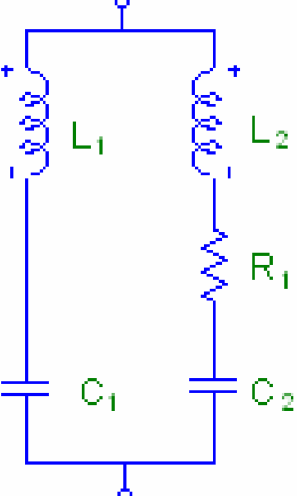
FIG. 2. (Color) Circuit drawing of each of 38 modified Marx generator stages. Here C (cid:5) 5 (cid:2) H , and the coupling between L 440 (cid:2) H , L 2 (cid:5) k (cid:8) L (cid:9) 1 = 2 (cid:5) 15 (cid:2) H L M 12 12 1 2